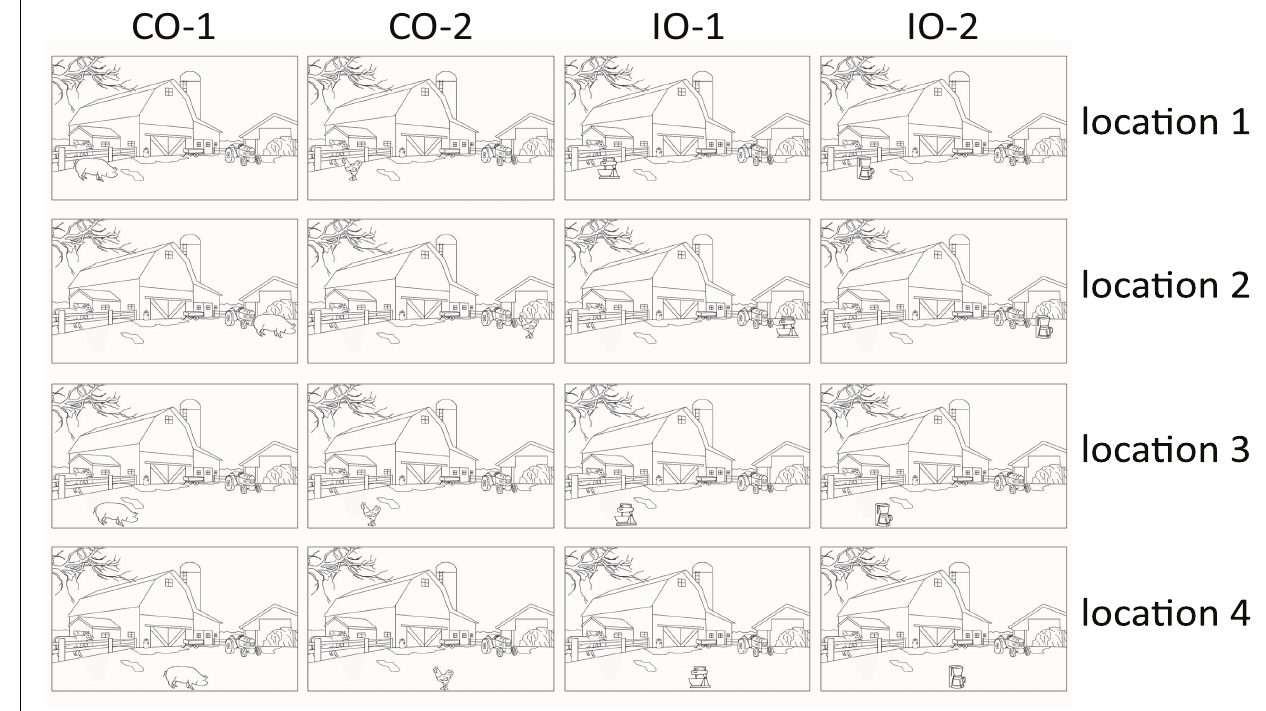
a chicken; inconsistent objects are a mixer and a coffee machine. (Note that the identity of consistent and inconsistent objects was fully balanced across the images. A mixer and a coffee machine, for example, were used as scene-consistent objects in kitchen images. This is not depicted.) The words Starten , Huhn , and Schwein are German for start , chicken , and pig ,